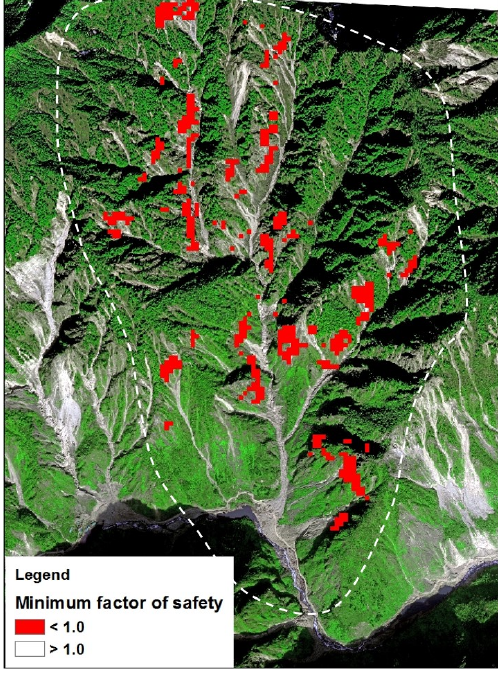
Figure 9. Computed unstable cells vs. landslide scars on the satel- lite